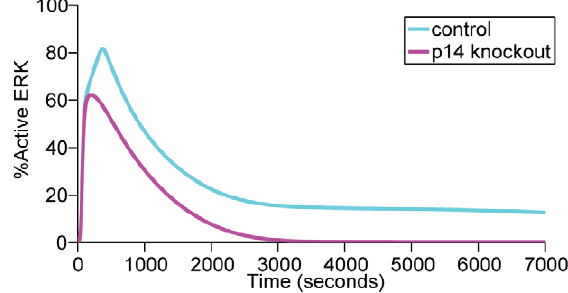
Figure 5. Profile of ERK activation before and after p14 knockout. The amount of active ERK produced in the later phase ( . 600 seconds) is reduced.